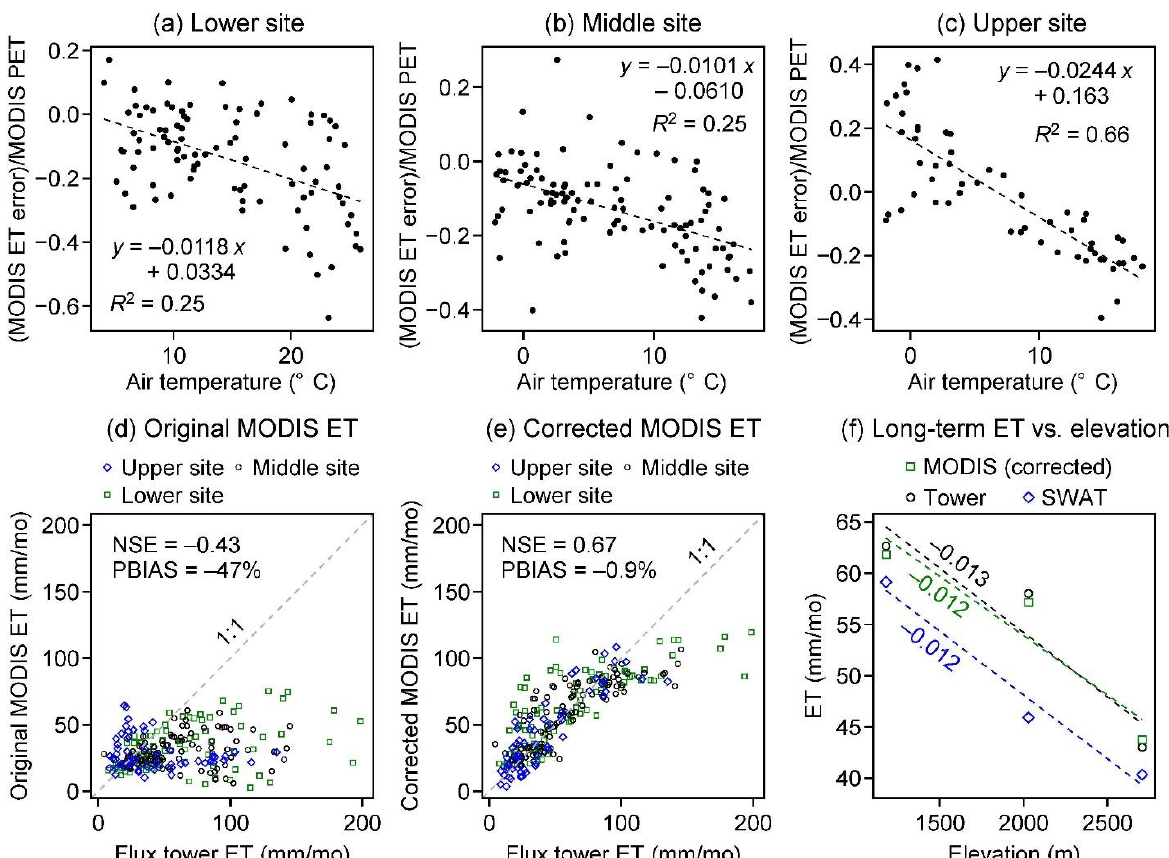
Figure 7. Weather correction to MODIS monthly ET using linear regression with air temperature as predictor variable. ( a – c ) Results of linear regression between MODIS ET error, as fraction of MODIS potential ET, and monthly air temperature for each site. MODIS ET error is defined as MODIS ET—flux tower ET. ( d ) Original (uncorrected) MODIS ET versus flux tower ET shown with 1:1 line. ( e ) Weather-corrected MODIS ET versus flux tower ET. ( f ) Average monthly ET from weather-corrected MODIS, flux tower, and SWAT versus elevation for comparison to Figure 3. Dashed lines are trendlines from linear regression, labeled with value of slope.